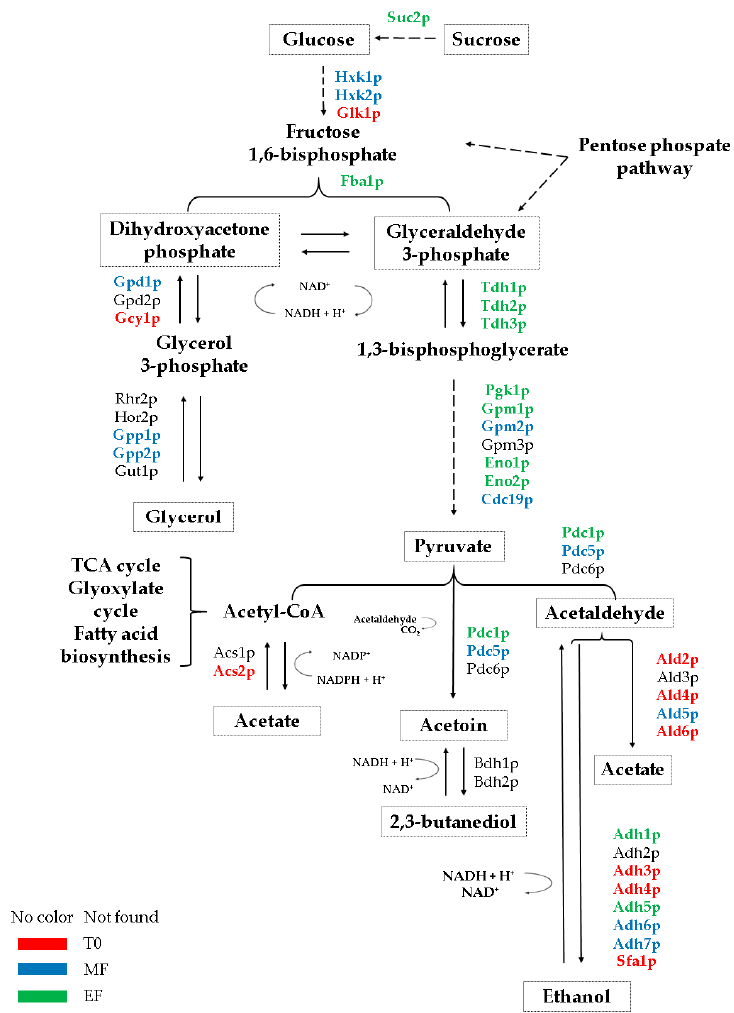
Figure 4. Summary of the scheme of proteins involved in the compounds derived from Saccharomyces cerevisiae flor yeast fermentation during the second fermentation in the production of sparkling wine. The color of the protein names represents the condition in which the highest protein content of the proteins was identified. Each condition is represented by a color: red for the base wine, T0; blue for the middle of the fermentation, MF; green for the end of the second fermentation,